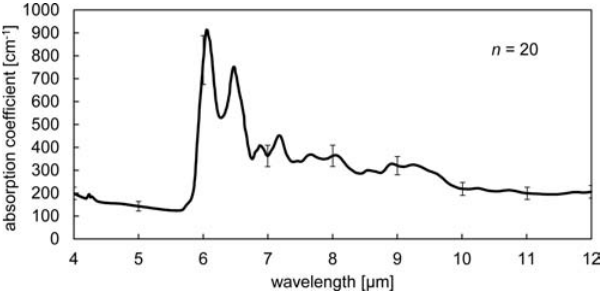
Fig. 3. Absorption coe±cient for chicken breast tissue.